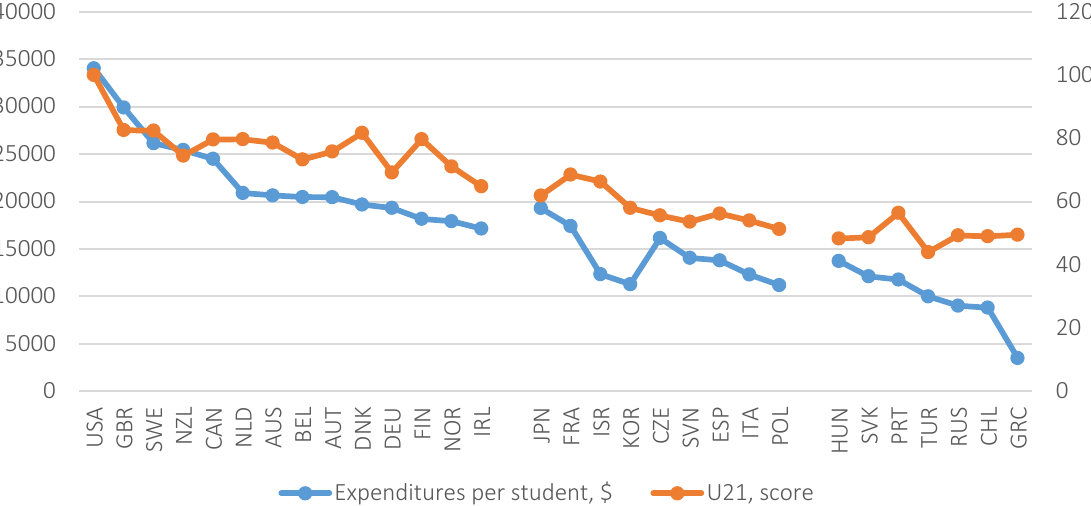
Figure 2. The relationship between the amount of higher education expenditures and the quality of higher education within